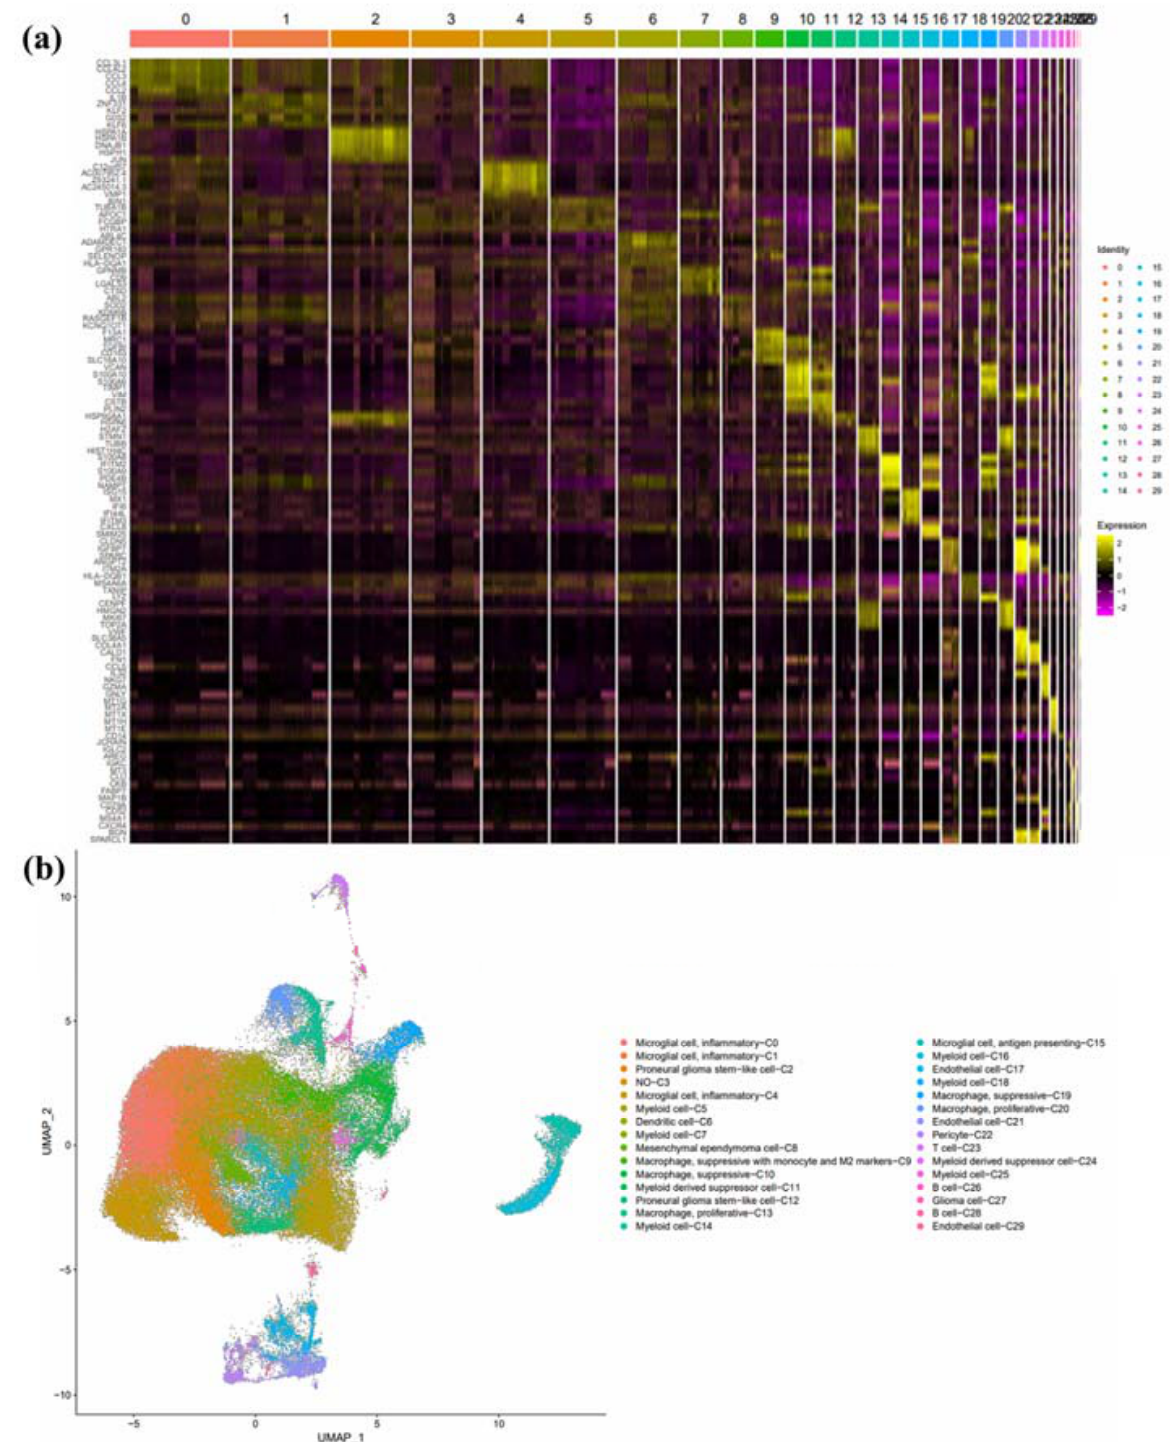
Figure 1. Cell clusters acquired from single-cell RNA sequencing analysis. The 30 clusters resulting from single-cell RNA sequencing analysis were visualized by ( a ) heatmap and ( b ) UMAP.